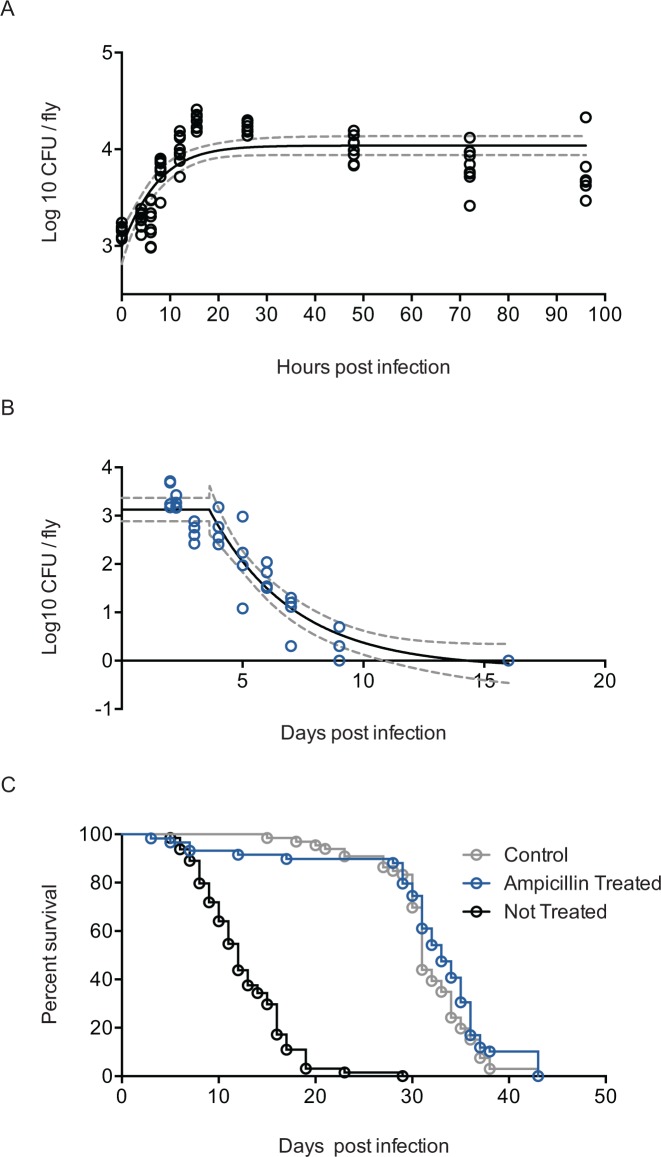

Listeria monocytogenes growth characteristics in the fly.(A) L. monocytogenes growth dynamics during infection. w1118 flies were injected with 1,000 CFUs. Individual flies were homogenized and plated, and bacterial colonies were counted at each time point. The data are fit with a logistic curve with a maximal growth ceiling of approximately 17,000 bacteria and a growth rate of 0.1659/h. The dotted lines indicate the 95% confidence interval. (B) L. monocytogenes dynamics during antibiotic treatment. Flies were injected with 100 CFUs and treated with ampicillin. The data are fit with a plateau followed by a one-phase decay with a half-life of 2.4 d. The dotted lines indicate the 95% confidence interval. (C) Survival curves for treated and untreated flies demonstrate that antibiotic treatment led to recovery of the flies, which lived as long as wounding control flies. Data are reported in S1 Data.